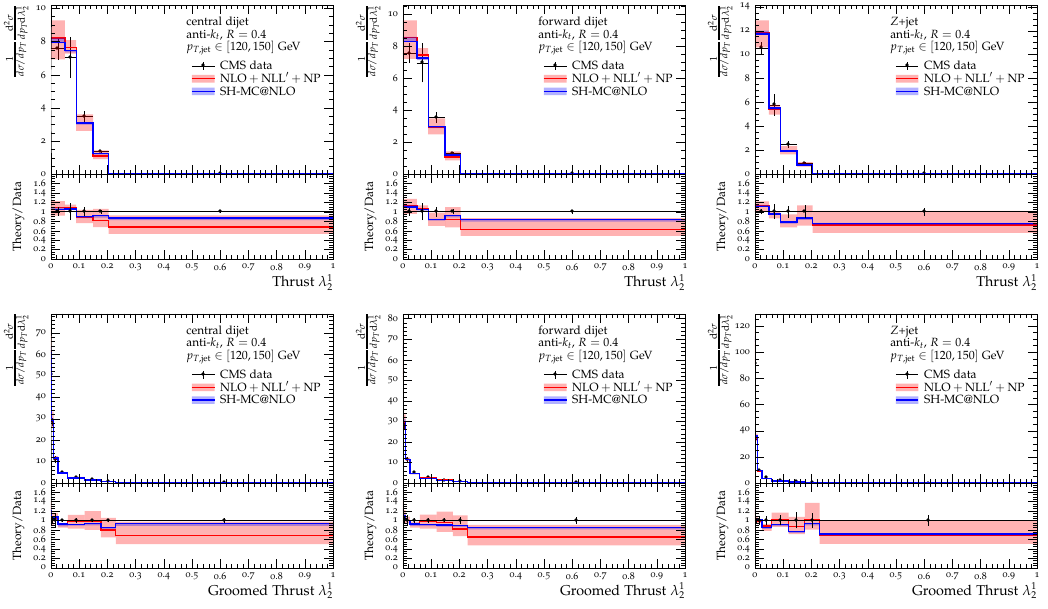
Figure 15. Same as figure 13 but for jet thrust λ 1